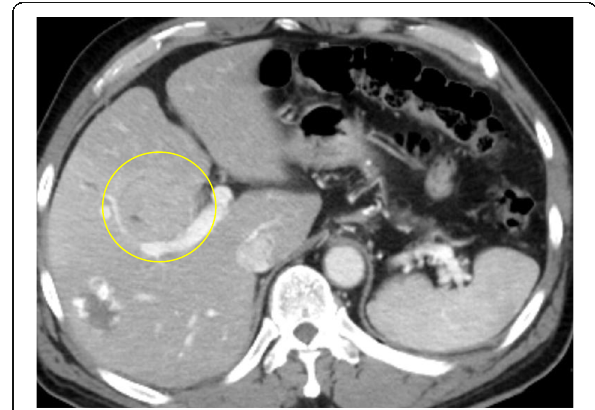
Fig. 1 Preoperative abdominal computed tomography showed a 50 × 48 mm hepatic mass that pressed the anterior